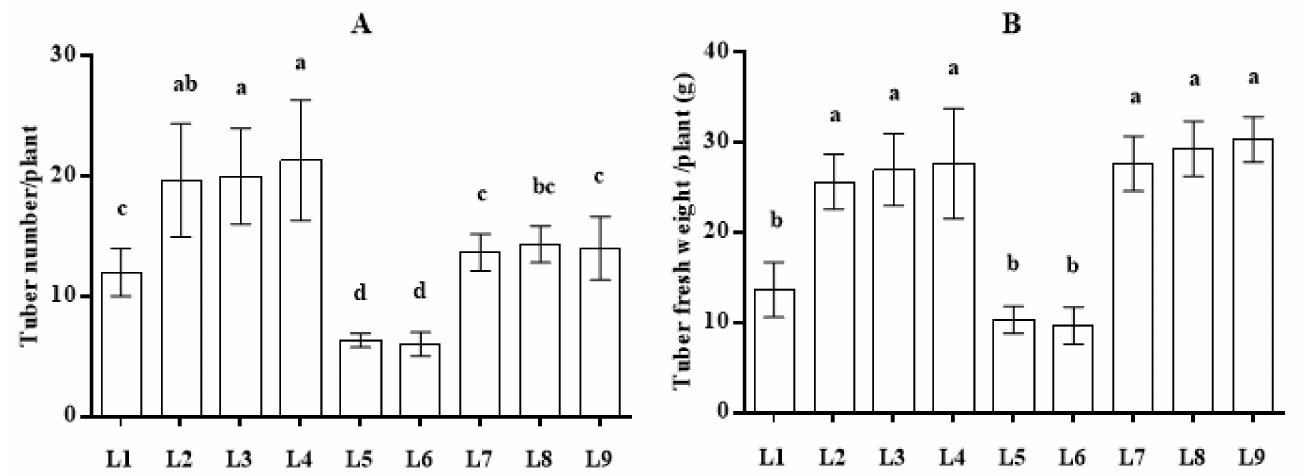
Figure 2. Effect of different LED light on tuber number ( A ) and tuber fresh weight ( B ) of potato plants grown under aeroponic system. Different letters indicate significant differences ( p ≤ 0.05) among the treatments within each parameter. Each value represents the mean ± SD (n = 3). L1 = natural light, L2 = R:B, L3 = R:B:G, L4 = R:B:FR, L5 = R:B:G:FR, L6= R:B:G:FR:UV, L7 = R:B:FR:UV, L8 = R:B:W:FR, L9 =